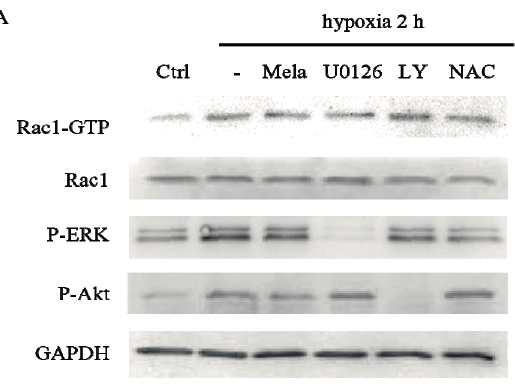
Figure 6. Melatonin reverses hypoxia-activated Rac1 activation and cell migration mediated through ERK. ( A ) The effect of PI3K, ERK and ROS on hypoxia-stimulated Rac1 activation. After treatment with 10 µM LY294002, or 10 µM U0126, or 1 mM NAC for 1 h, cells were incubated under hypoxia for 2 h, and cell lysates were analyzed for Rac1 activation by pull-down assays. Each bar graph represents the mean ± SD of three independent experiments. * p < 0.05, referring to the difference between cells treated with and without hypoxia; # p < 0.05, referring to the difference between cells treated with hypoxia plus melatonin or U0126 and relative to the cells exposed to hypoxia alone; ( B ) The effect of hypoxia on ERK activation. Cells were incubated under normoxia or hypoxia for the indicated time. Cellular lysates were assayed for ERK phosphorylation; and ( C ) The effect of ERK inhibitor U0126 on hypoxia-stimulated cell migration. After pretreatment with 10 µM U0126 for 1 h, cells were exposed to hypoxia for 24 h, and the cell migration rate was determined by wound closure assay. * p < 0.05, referring to the difference between cells treated with and without hypoxia; # p < 0.05, referring to the difference between cells treated with U0126 plus hypoxia relative to the cells exposed to hypoxia